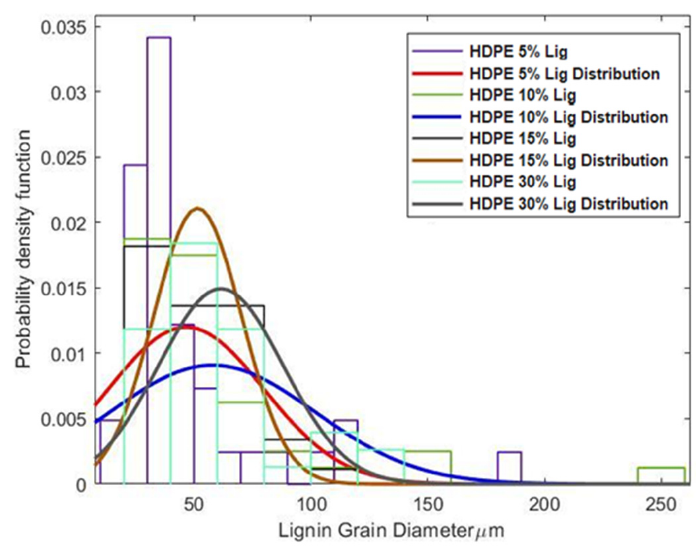
Figure 8. Frequency distribution showing lignin particle size.